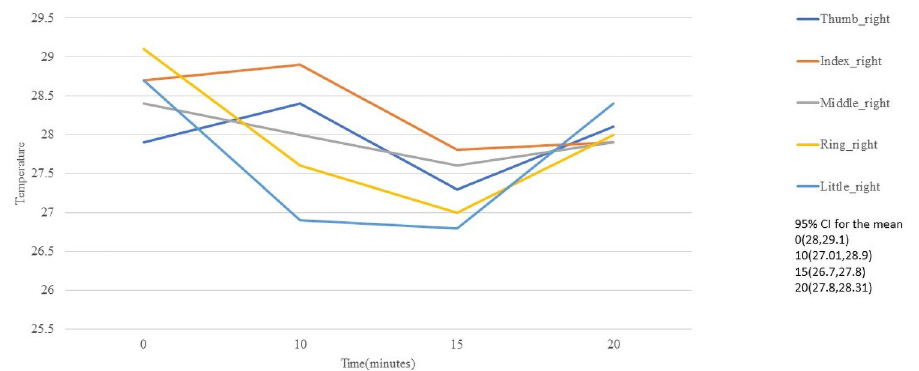
Fig 7. Temperature behaviour of the fingers in palmar right hand.